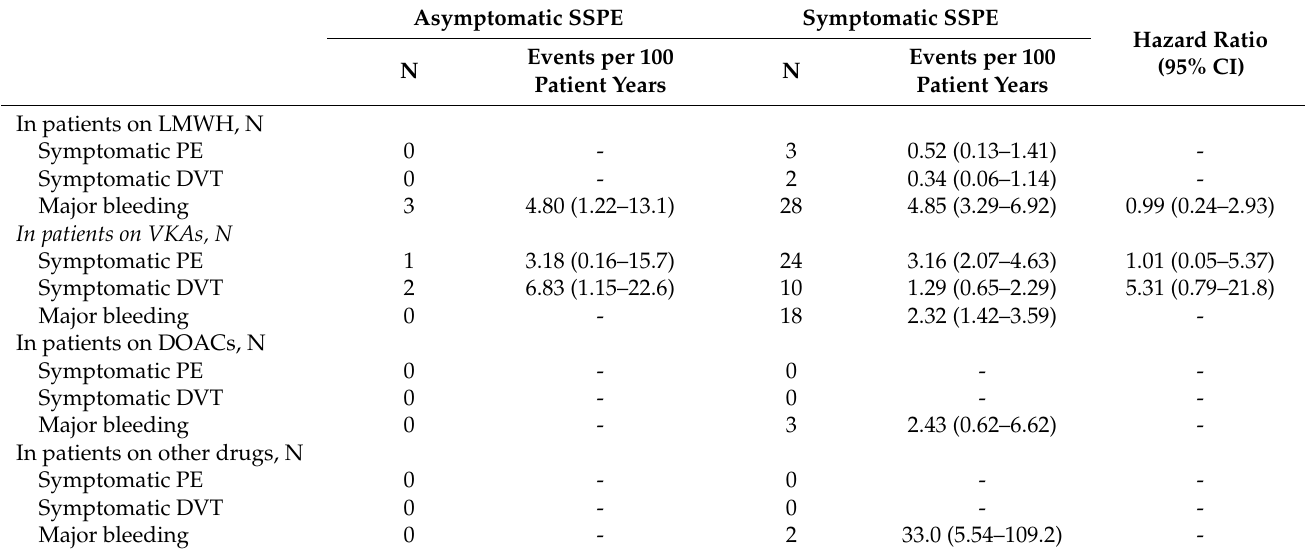
Table 4. Recurrent venous thromboembolism and major bleeding during the course of anticoagulant therapy, according to the drugs used.